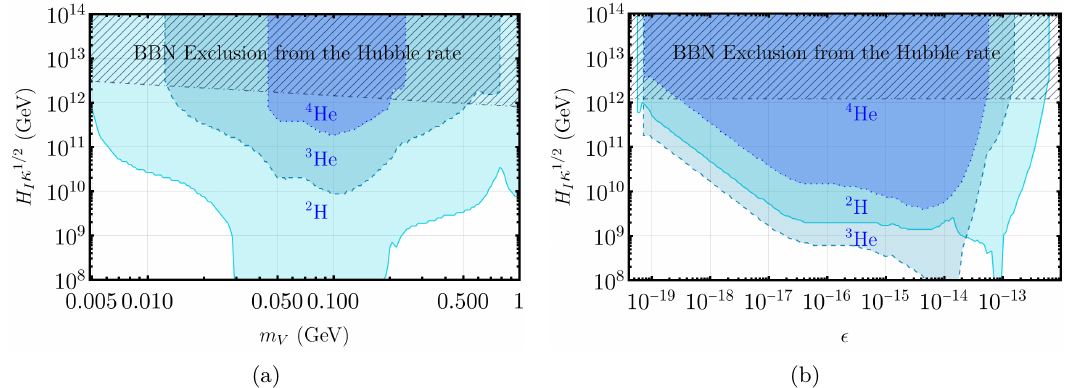
Figure 1 . Left panel: the BBN constraints on a dark photon with mass m V with kinetic mixing parameter to the SM photon (cid:15) = 5 × 10 − 14 for high reheating scenario T . 10 15 GeV. H is the RH I Hubble scale at the end of inflation, while κ is an order of one parameter to take into account the dependence on inflationary models. The dashed area “BBN exclusion from the Hubble rate” is ruled out at 95% CL since the energy density of the dark photon is large enough to affect the BBN through the modification of the Hubble rate during the BBN. Further 95% CL exclusion regions delimited by solid, dashed, and dotted lines are due to the BBN photodisintegration constraints from the measurements of primordial abundances of 2 H, 3 He, and 4 He, respectively. Right panel: exclusion regions for m = 0 . 2 GeV in the plane of H 1 / 2 and (cid:15) V I κ